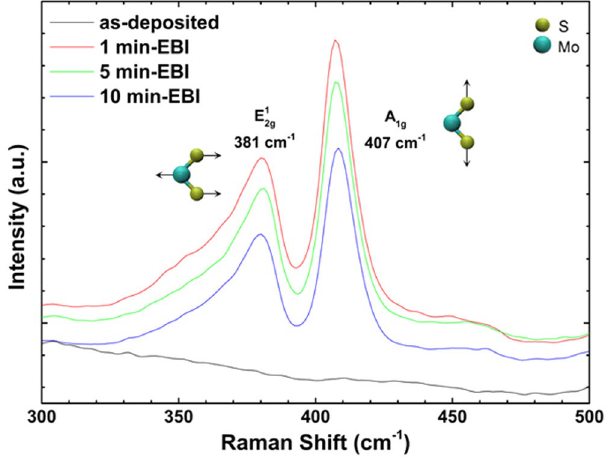
Figure 1. Raman spectra of as-deposited and EBI-treated MoS 2 films according to irradiation times of 1, 5, and 10 min.